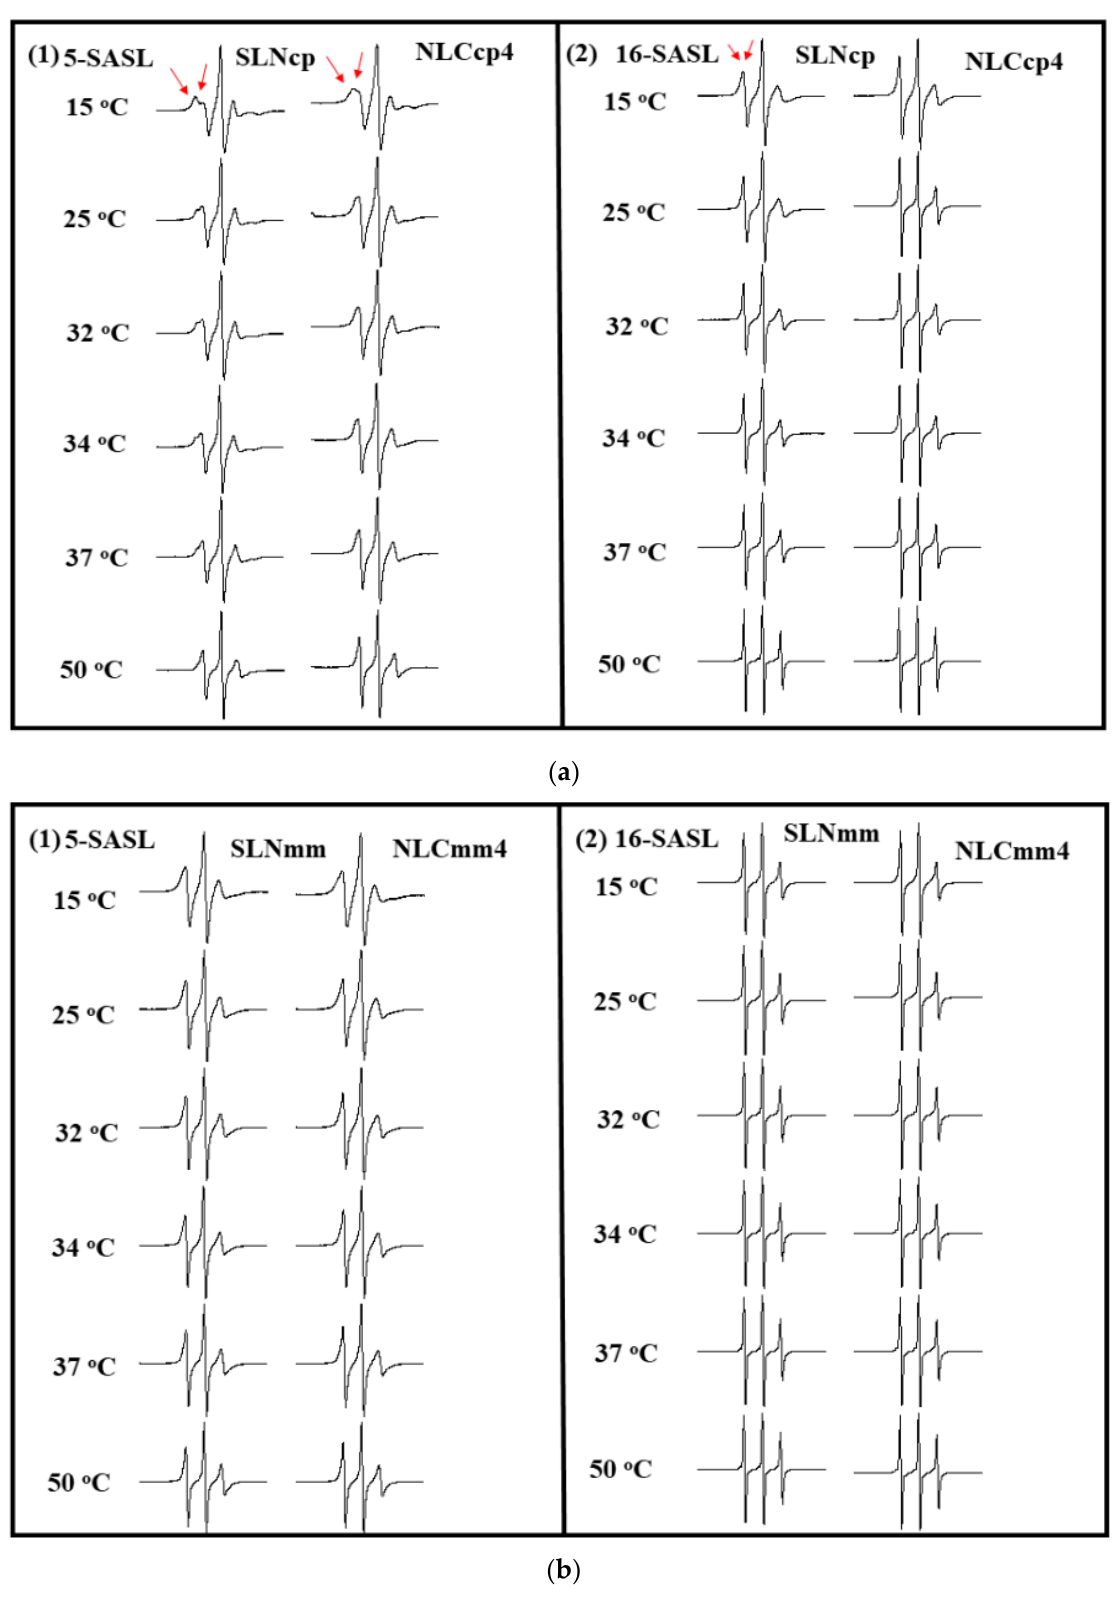
Figure 7. EPR spectra obtained with 5-SASL ( 1 ) and 16-SASL ( 2 ), inserted into nanoparticles; SLN and NLC4 (4% of AO) prepared with CP ( a ) and MM ( b ).